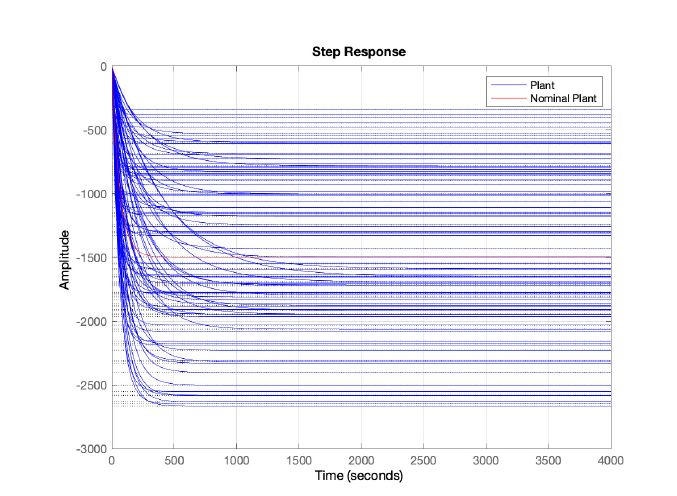
Figure 7. Step response for linear plants obtained around different equilibrium